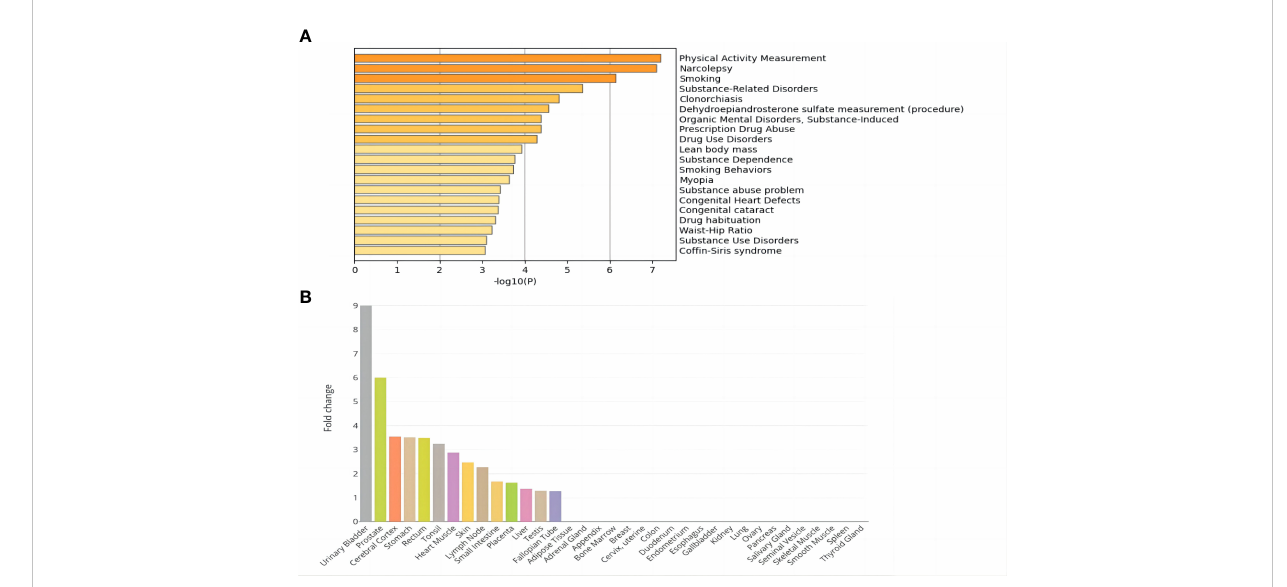
FIGURE 1 Enrichment analysis of shared genes in NAFLD and T2D. (A) DisGeNET enrichment analysis results. (B) Tissue enrichment